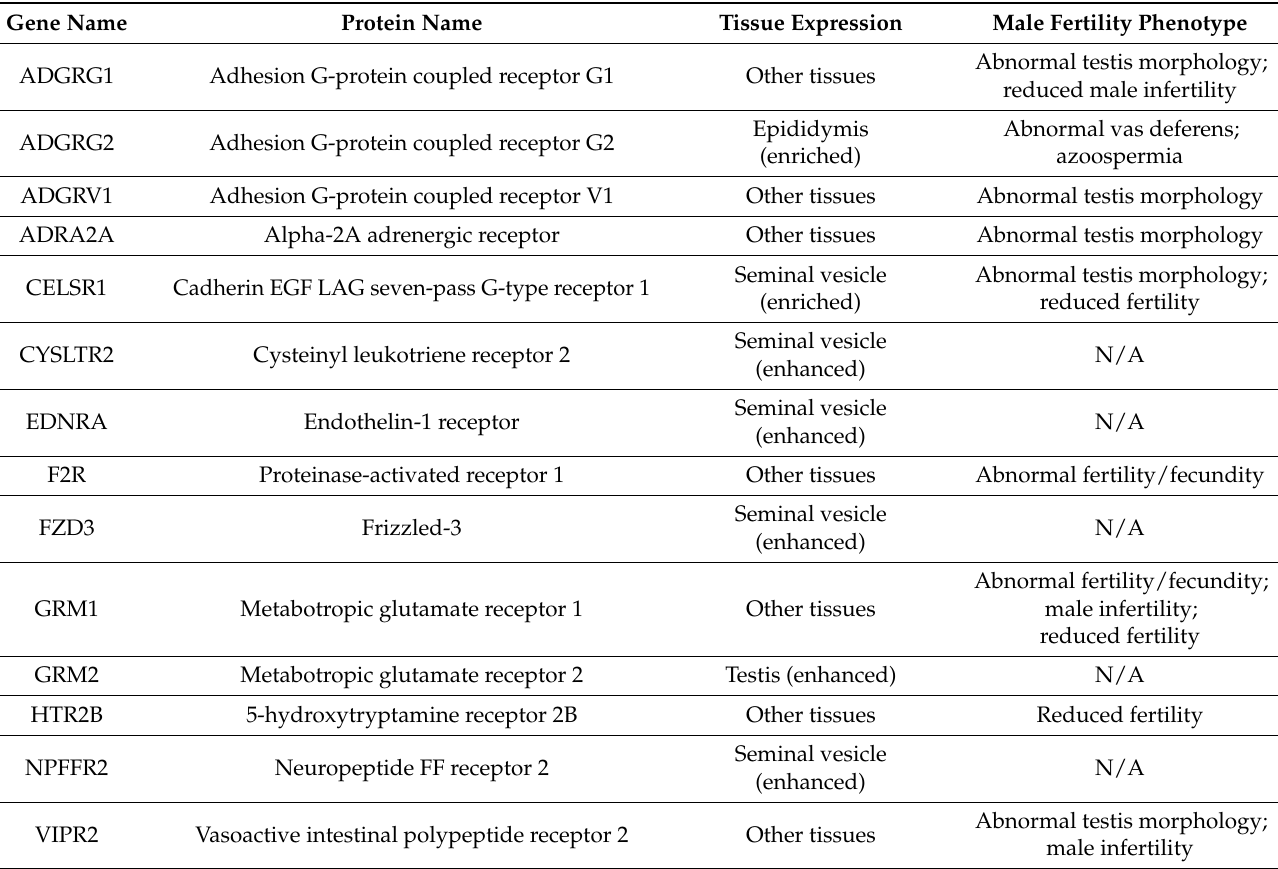
Table 2. GPCRs with selective expression in male reproductive tissues or associated with male infertility defects. For each GPCR, selective expression in male reproductive tissues and the male infertility phenotypes observed in knock-out mice are